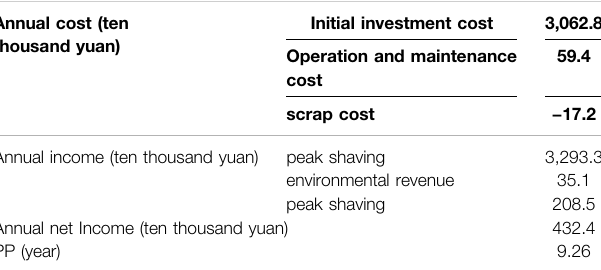
TABLE 4 | Annual costs and bene fi ts of “ peak cutting and valley fi lling ” .